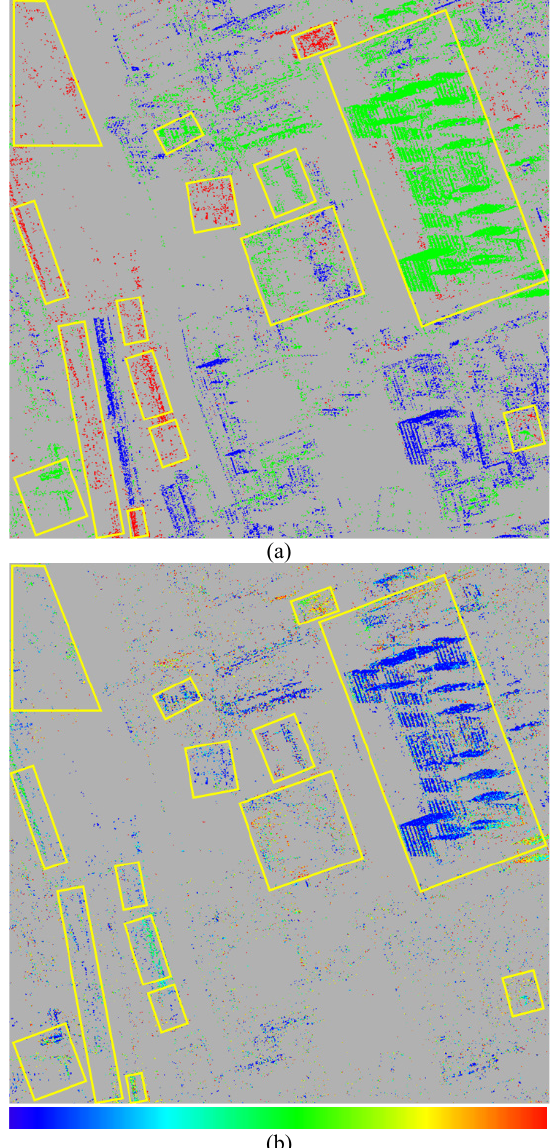
Figure 4. Spatiotemporal change detection result. (a) Steady, disappearing, and emerging structures represented by PS (blue), DBC (red), and EBC (green) points. (b) Occurrence dates: blue Figure 5. Original example. (a) Ratio image (potential changes to red, earliest to latest in 2013. Yellow square, building towards black and red). (b) Detected changes construction.